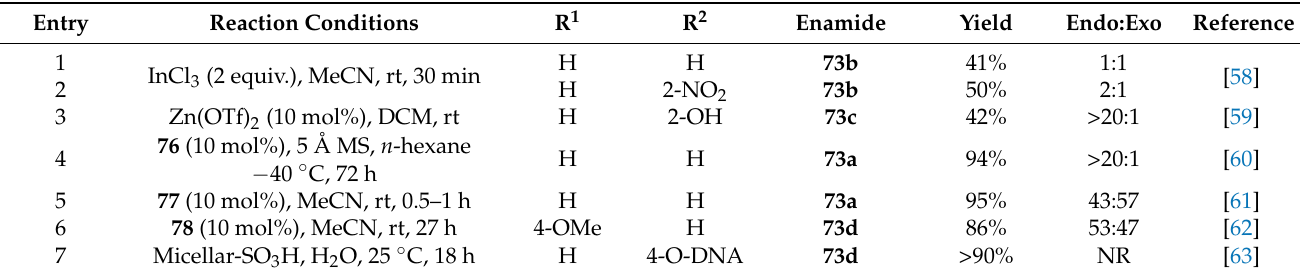
Table 2. Reaction conditions and outcome from the Povarov reaction between the aromatic imine 75 and enamide 73a – d (Scheme